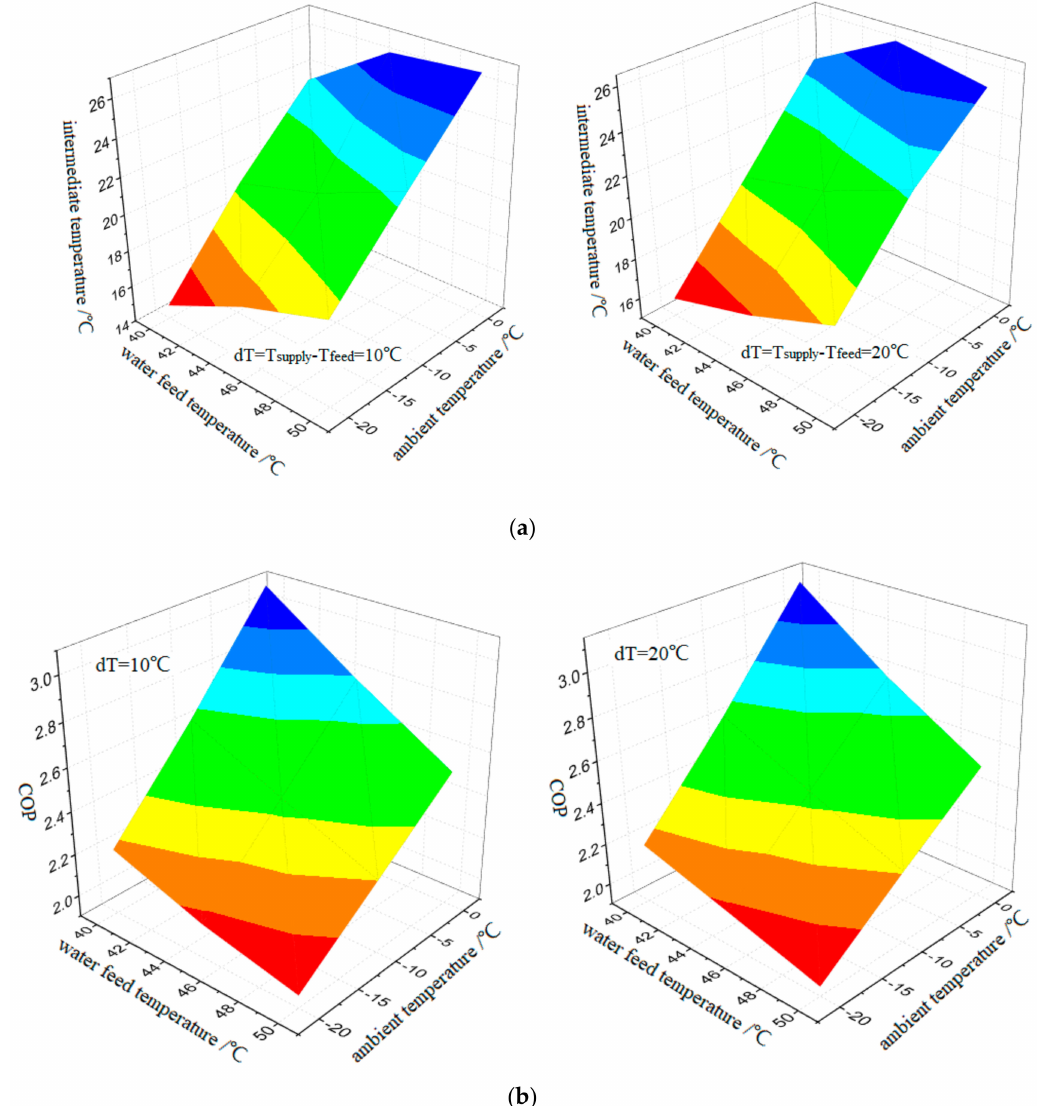
Figure 5. ( a ) The optimal intermediate temperature versus the operating conditions (water-feed temperature and ambient temperature); ( b ) the maximum system COP versus the operating conditions (water-feed temperature and ambient